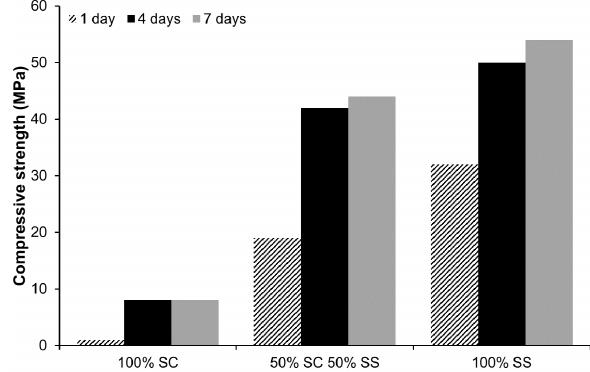
Figure 9: Effect of activator composition on early age compressive strength (adapted from [40])